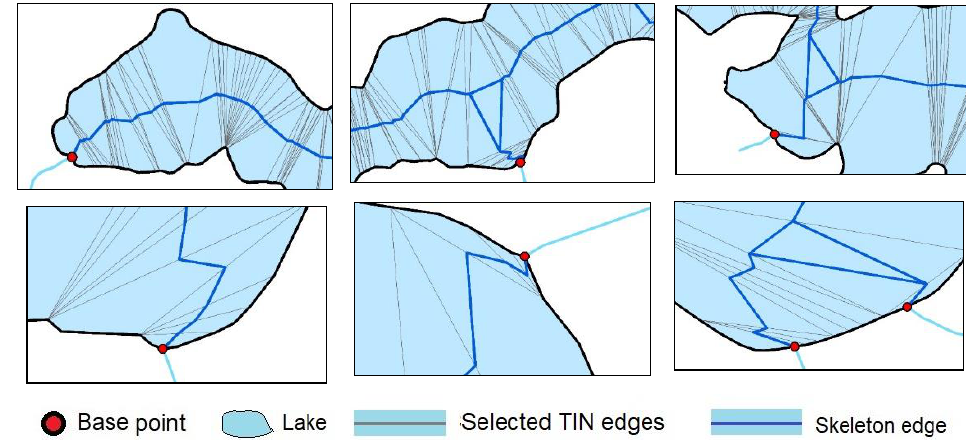
Figure 20. Different geometric figures in boundary segments near base points.